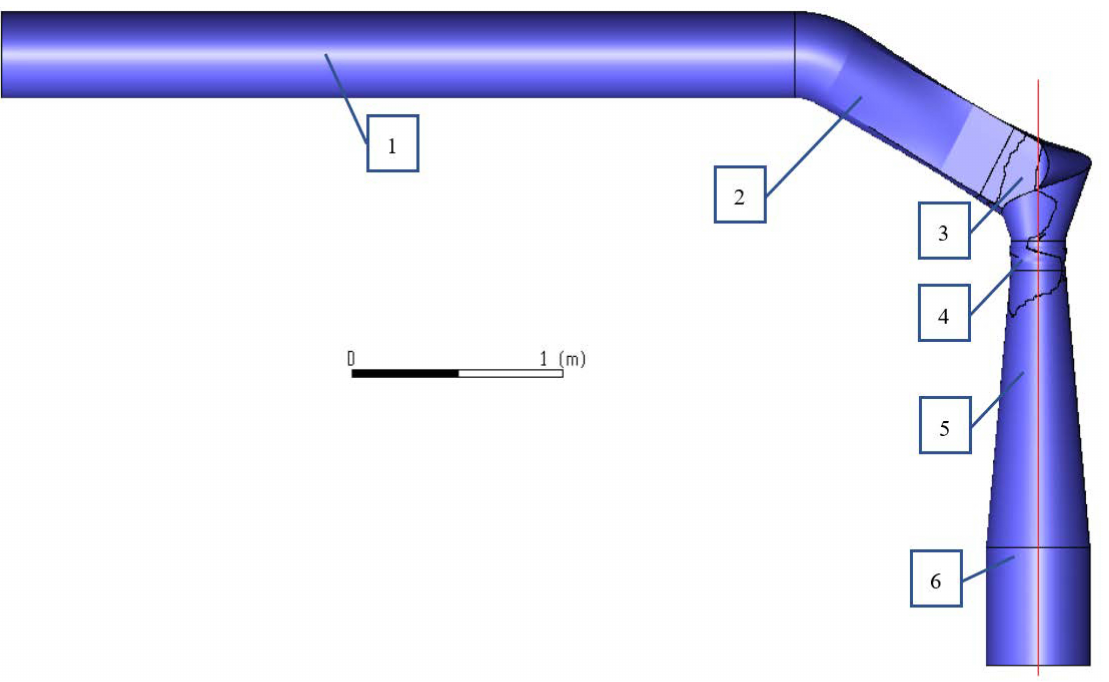
Figure 6. Computational domain used in CFD calculations.